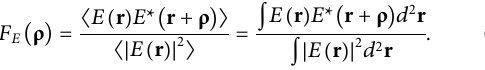
Figure 7 as follows: the arithmetic-mean deviation of the pro fi le from the nominal surface line, R a = 〈 | h ( x , y )| 〉 , RMS deviation R q (12), the asymmetry coef fi cient of the distribution (skewness) Sk, and the excess coef fi cient (kurtosis) Ku. This example is obtained by simulation with the maximal interval of the surface inhomogeneity heights (the difference between the maximal and minimal heights) assumed to be Δ h max = 2 μ